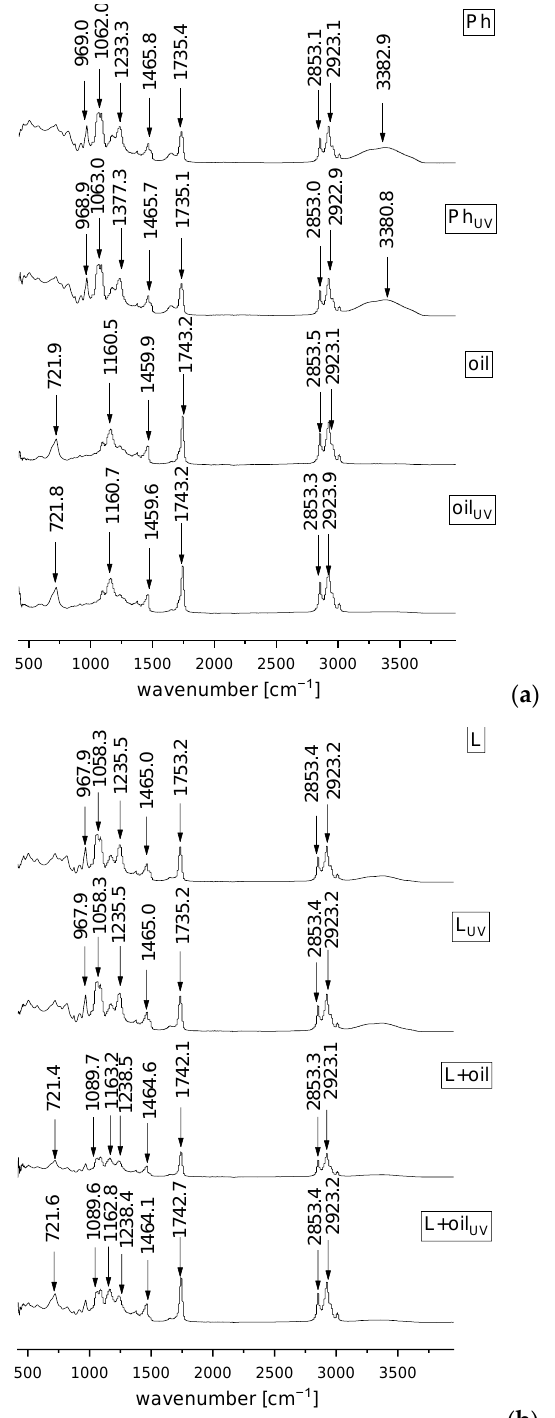
Figure 3. FT − IR spectra of the non-treated and UV-irradiated ( a ) Ph (a commercial phospholipids mixture) and Rosa canina seed oil, and ( b ) the plain and oil-loaded liposomes in the spectral range from 450 to 4000 cm − 1 ; L, liposomes.